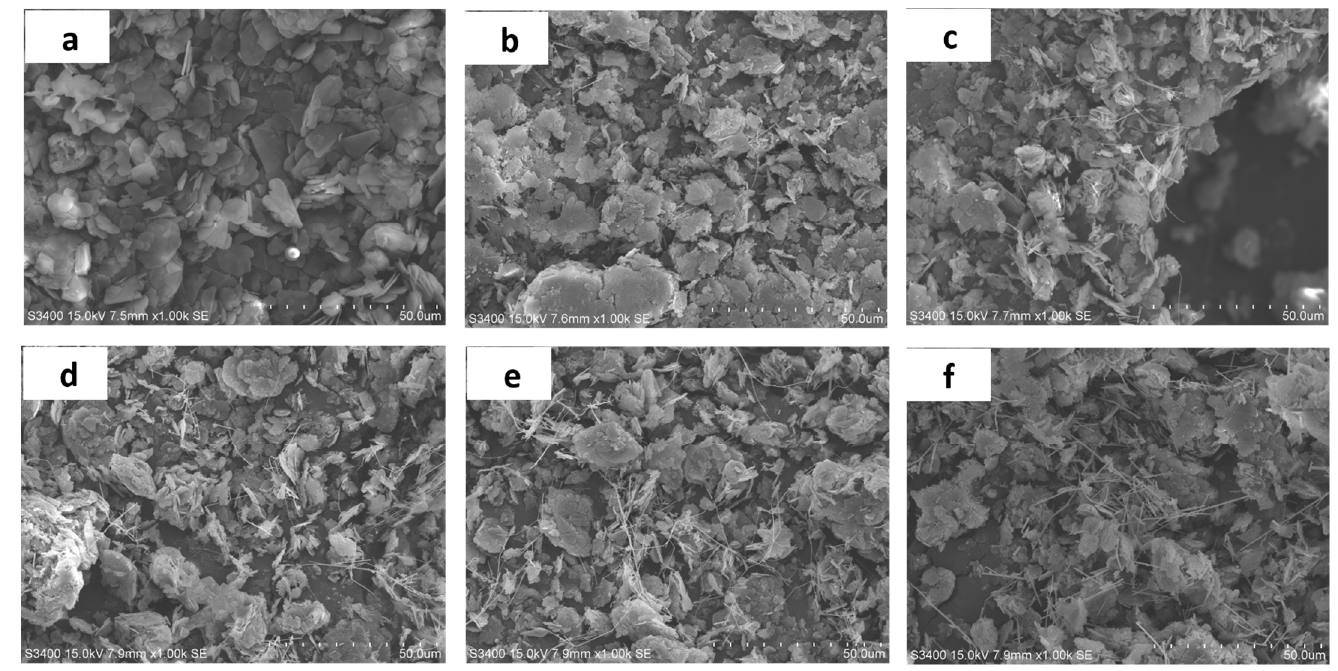
Figure 2. SEM images of ( a ) pure BN; ( b ) BN@5AgNWs; ( c ) BN@10AgNWs; ( d ) BN@15AgNWs; ( e ) BN@20AgNWs; ( f ) BN@25AgNWs.